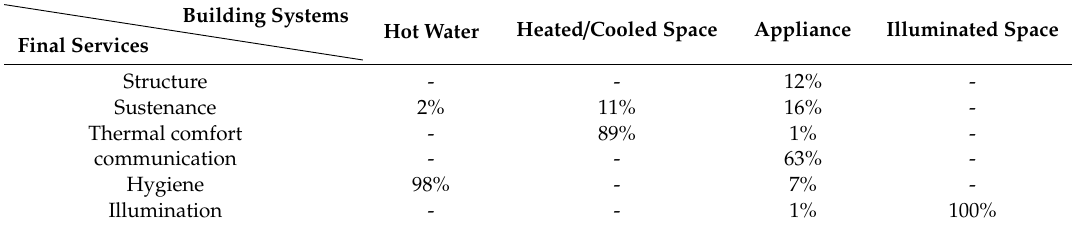
Table A8. The shares of final services from building systems in China in